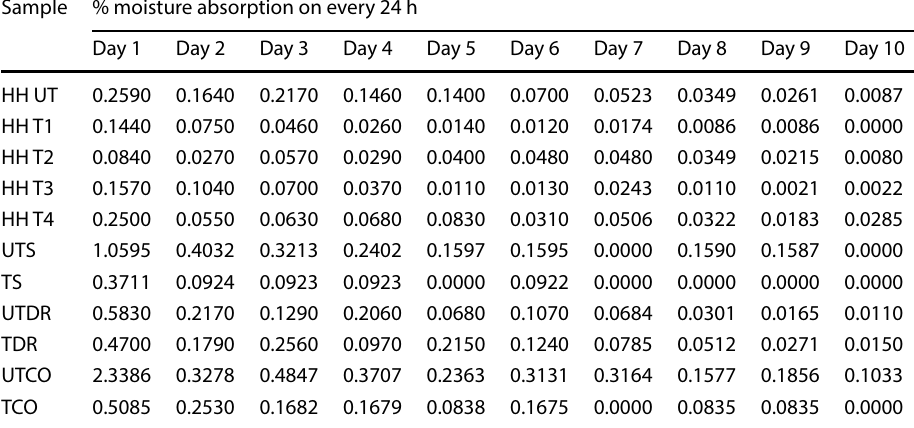
Fig. 6 FTIR spectrum of untreated and treated Caryotta Obtusa